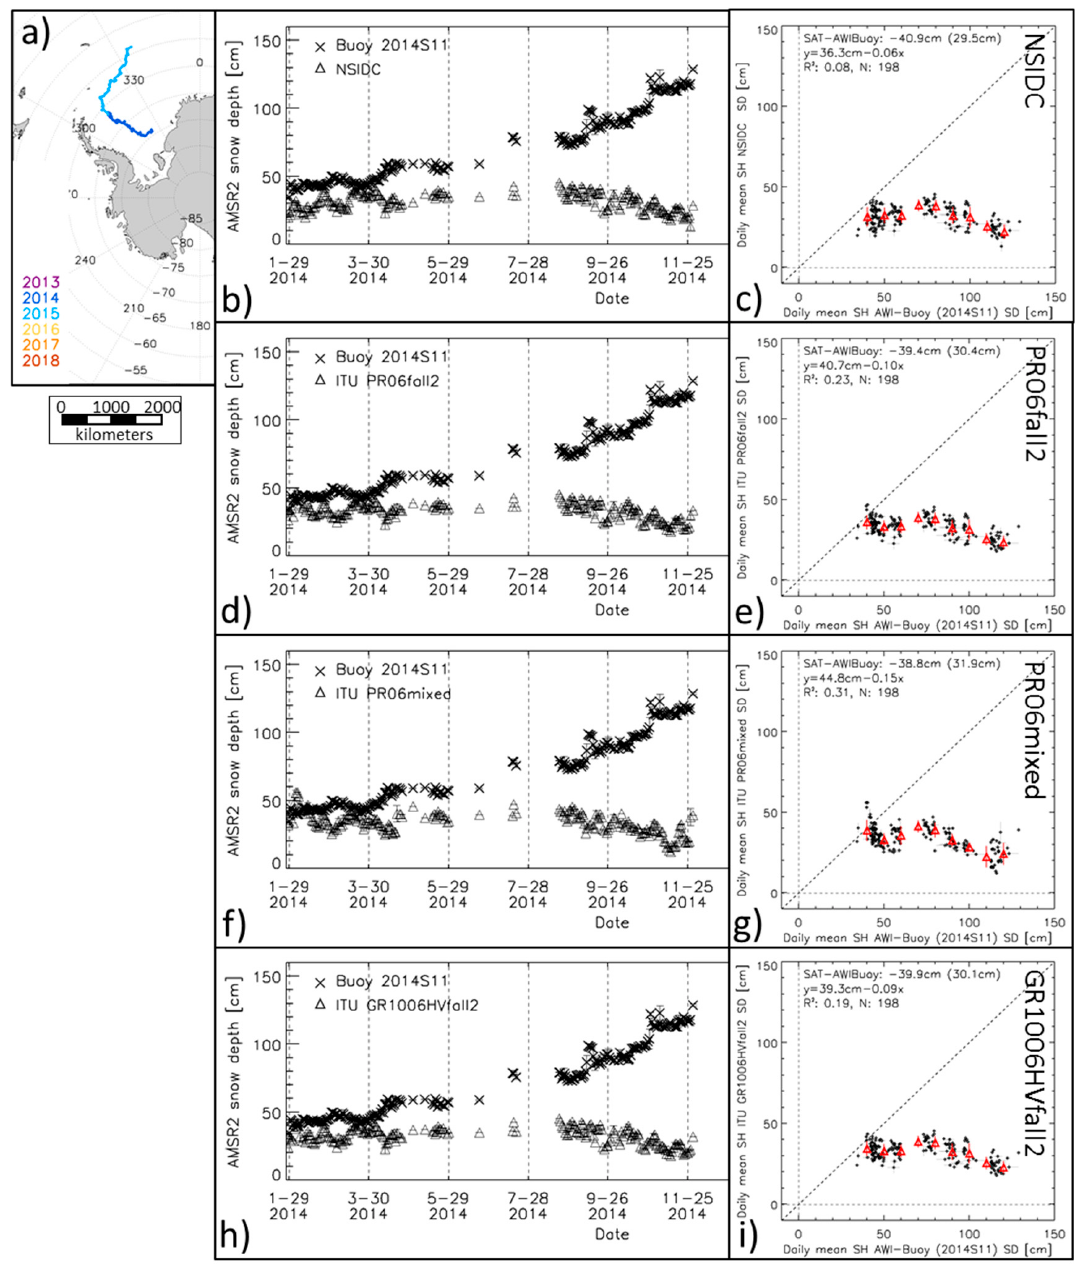
Figure 12. The results of the comparison between the AMSR2 snow depth and the snow depth observed by AWI buoy 2014S11. Panel ( a ) shows a map showing the track of the buoy color-coded according to the year of operation; panels ( b , d , f , h ) show the time series of the buoy (crosses) and NSIDC (triangles) snow depth; panels ( c , e , g , i ) show the scatterplots of the data shown in the time series. For colors and parameters given in the scatterplots, see the caption of Figure